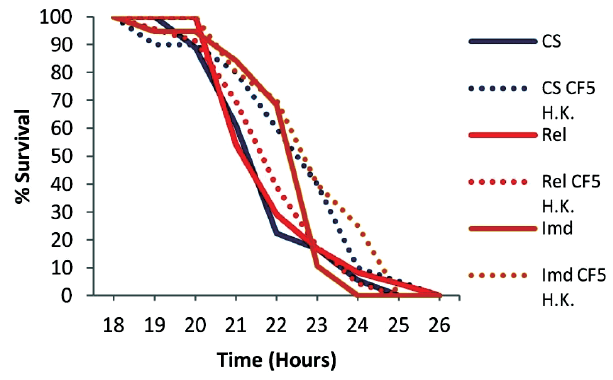
Figure 6. Survival kinetics of wt and humoral response deficient flies 7 days post priming with heat-killed Pseudomonas aeruginosa CF5. Wild type Canton S (CS), Imd and Rel mutant primed and non primed flies were tested. All fly genotypes exhibited no significant effect, CS (P=0.0726), Rel (P=0.9163), Imd (P=0.0663), indicating that priming is transient. n=18–24 flies per condition.